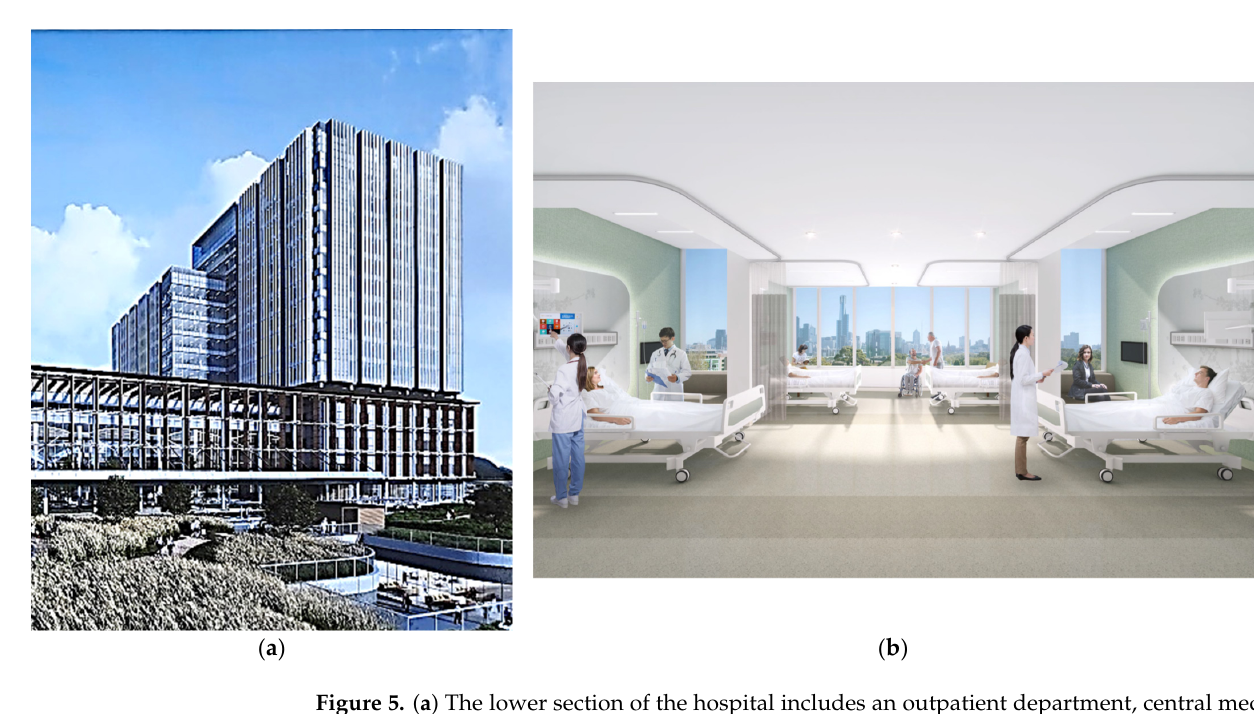
Figure 5. ( a ) The lower section of the hospital includes an outpatient department, central medical labs, and administrative department. The upper tower is dedicated to an inpatient department. Unlike the typical hospitals, the overall shape of the tower is not linear but rectangular to enhance the daylight condition in the inpatient wards and to reduce the corridor length traveled by nursing staff; ( b ) The design of the four-person inpatient unit type is devised to improve the daylight, view, and privacy for each patient by an extensive exterior glazed window, an alcove-shaped room, and bed arrangement. (Source: ( a ) photo by author taken from the construction site, ( b ) image from Samoo Architects and Engineers; The original competition-winning design was proposed by Samoo Architects and Engineers).